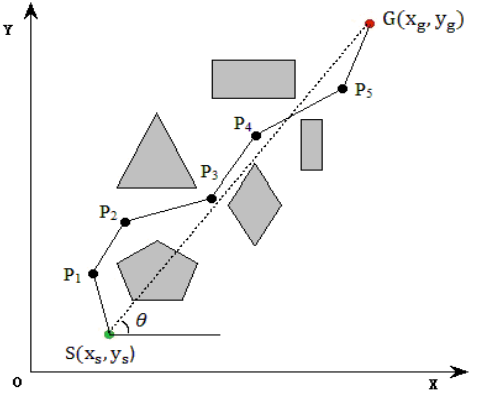
Figure 1. The path map of mobile robot movement environment.